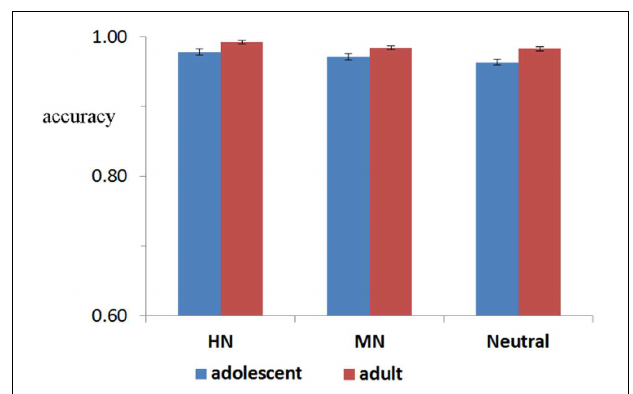
FIGURE 2 | The accuracy for adults and adolescents during HN, MN, and Neutral stimuli.